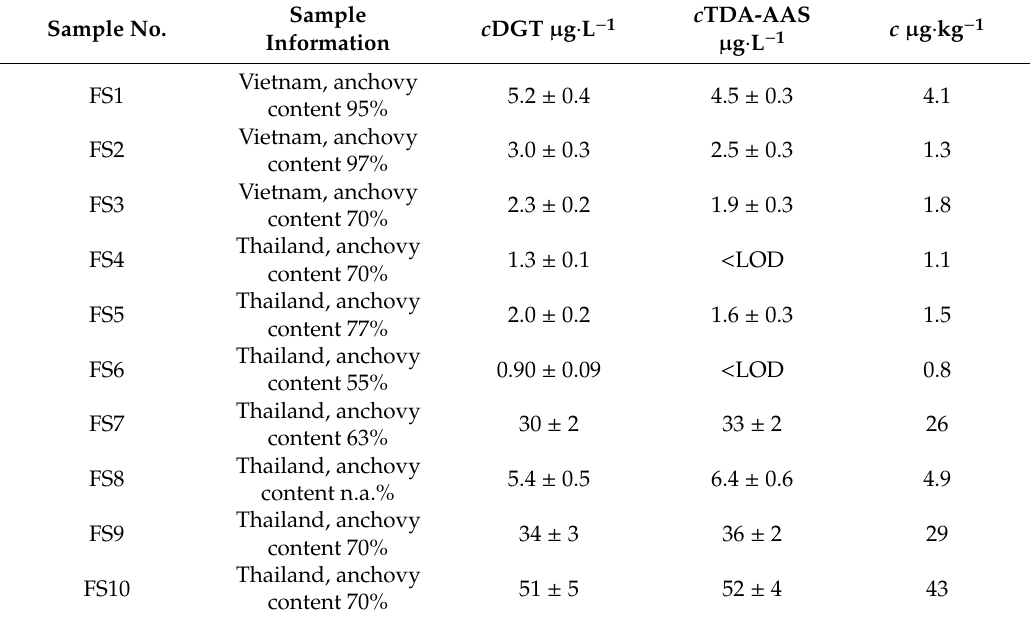
Table 2. Concentration of Hg in fish sauce samples measured by direct analysis ( c TDA-AAS) and by application of DGT ( c